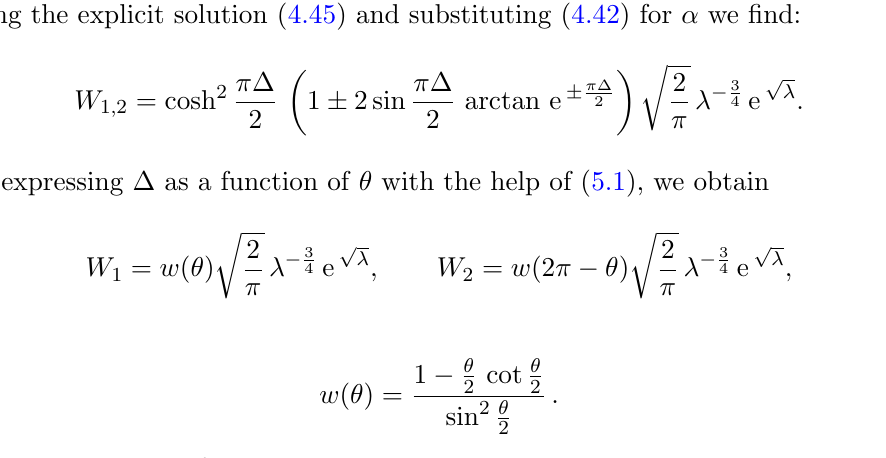
Figure 5 . The circular Wilson loops in the quiver theory normalized by that in the N = 4 SYM, plotted as a function of the (cid:18) -parameter. The dots represent the same data as in (cid:12)gure 4. Using the explicit solution (4.45) and substituting (4.42) for (cid:11) we